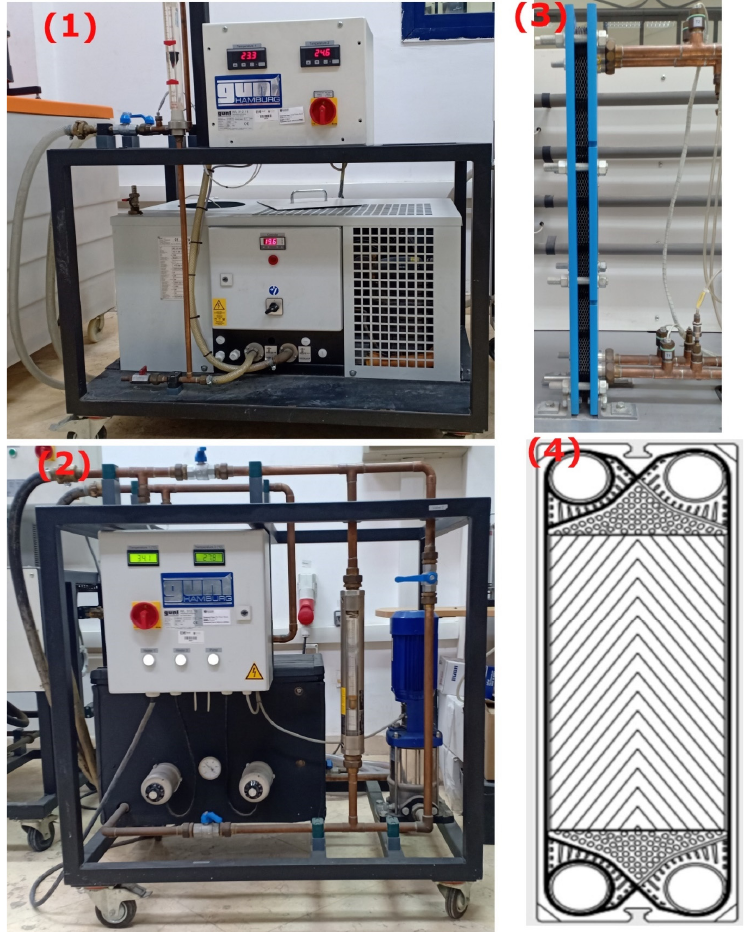
Figure 1. Schematic diagram for the experimental setup components of ABI into CWS.